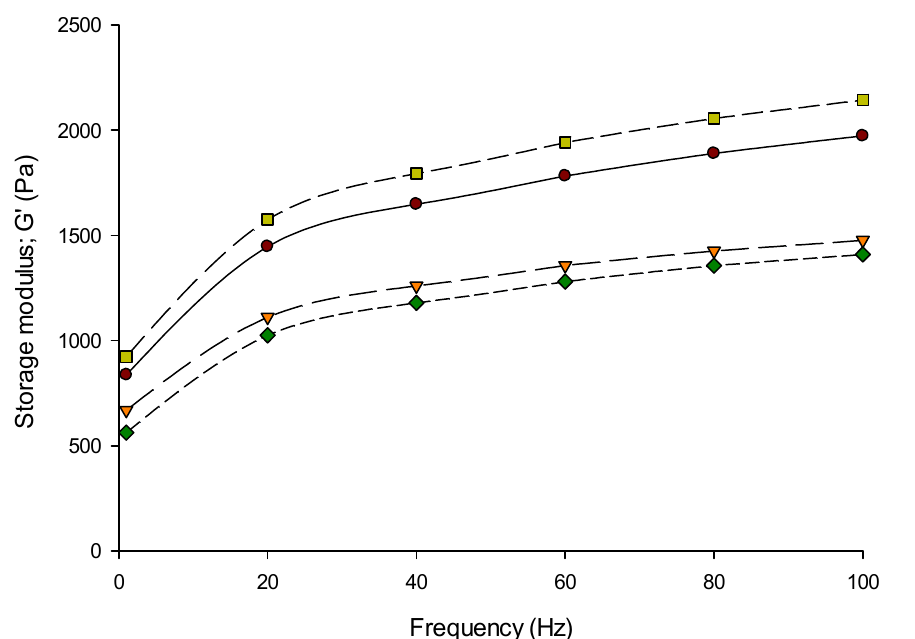
Figure 2. Elastic modulus (G ′ : Pa) of Feta-type cheese made from micellar casein concentrate (MCC). Treatment: Control ( ● ) = Feta-type cheese made from whole milk; MCC-3 ( ▼ ) = Feta-type cheese made from MCC solution with 3% protein; MCC-6 ( ■ ) = Feta-type cheese made from MCC solution with 6% protein; MCC-9 ( ♦ ) = Feta-type cheese made from MCC solution with 9% protein measured at a range of 0.1 to 100 Hz frequency at 20 °C using dynamic rheological analysis (DSR).